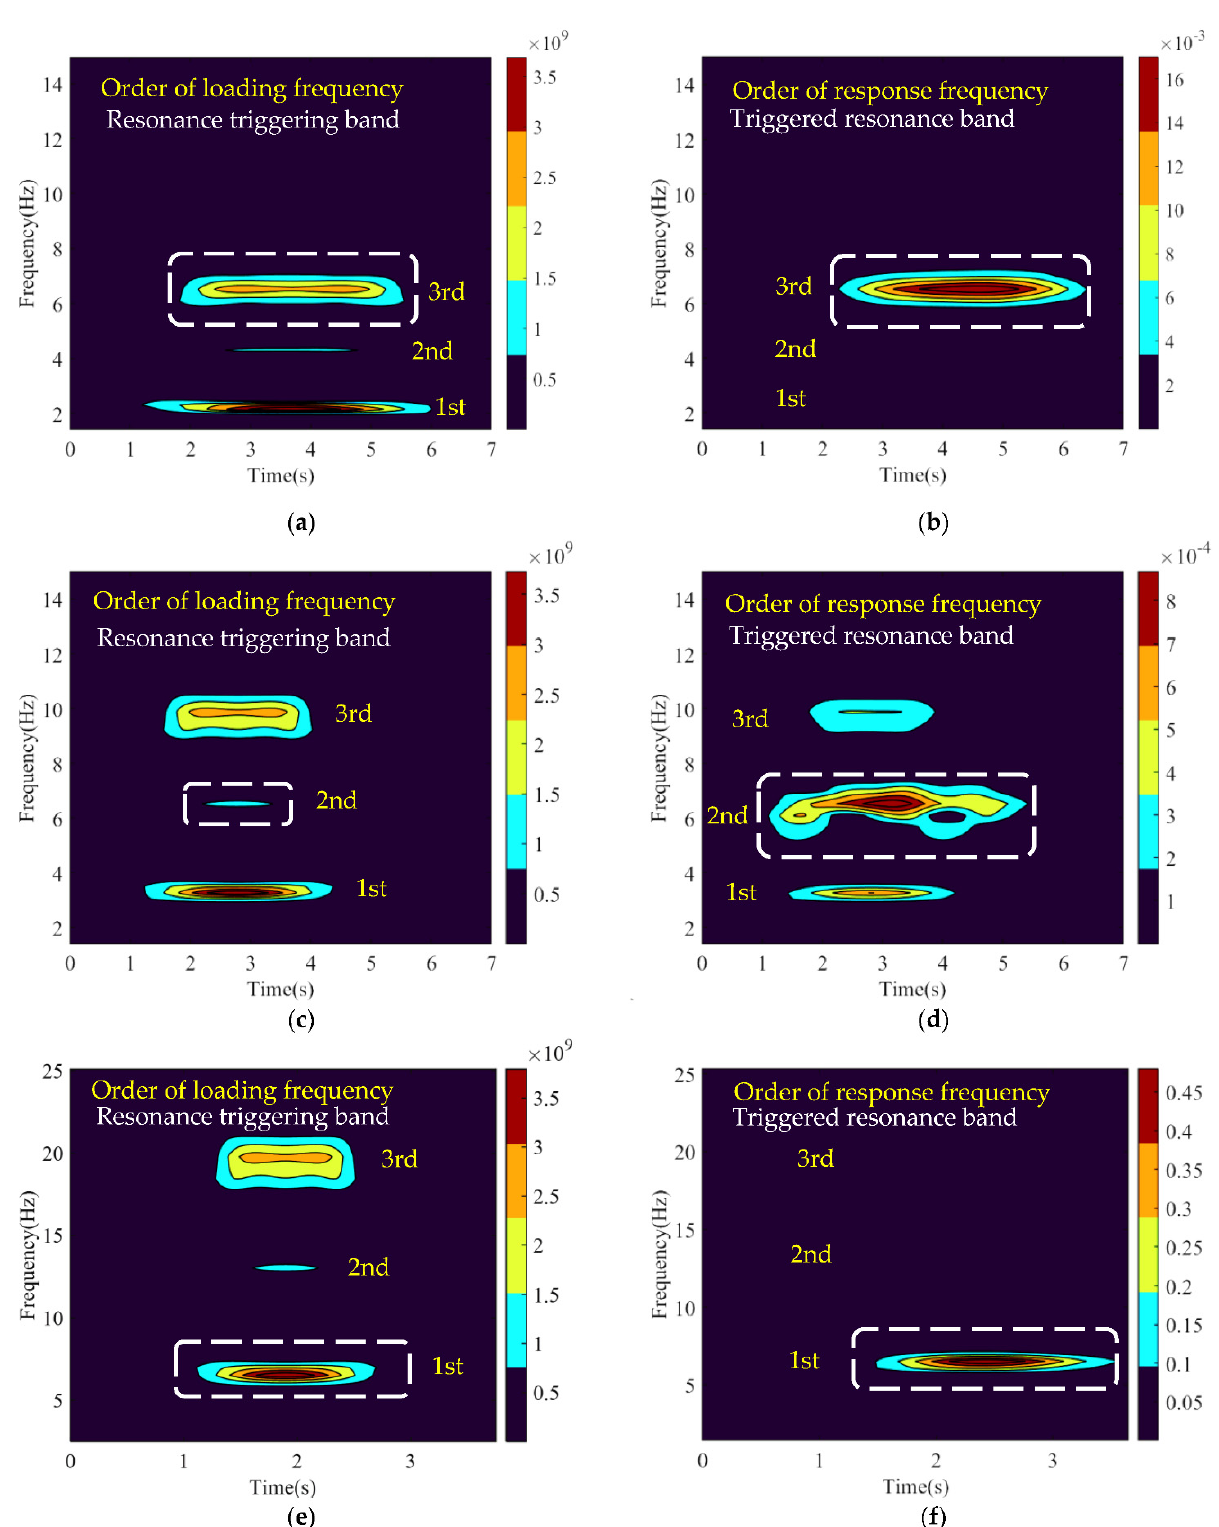
Figure 7. Scalogram from excitation to vertical vibratory resonant acceleration response at mid– span bridge: ( a ) Excitation scalogram at 195 km/h; ( b ) Bridge response scalogram at 195 km/h; ( c ) Excitation scalogram at 292.5 km/h; ( d ) Bridge response scalogram at 292.5 km/h; ( e ) Excitation scalogram at 585 km/h; ( f ) Bridge response scalogram at 585